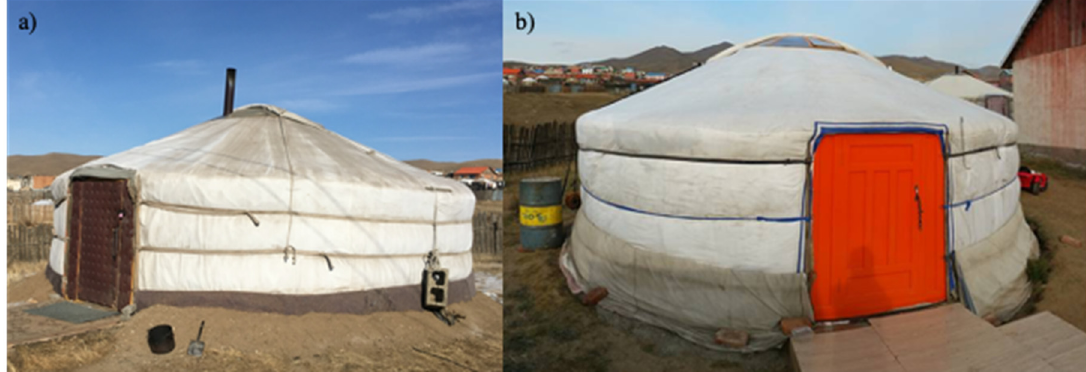
Figure 1. Two Mongolian gers installed for the experimentation: ( a ) The view of Ger 1; ( b ) Ger 2.